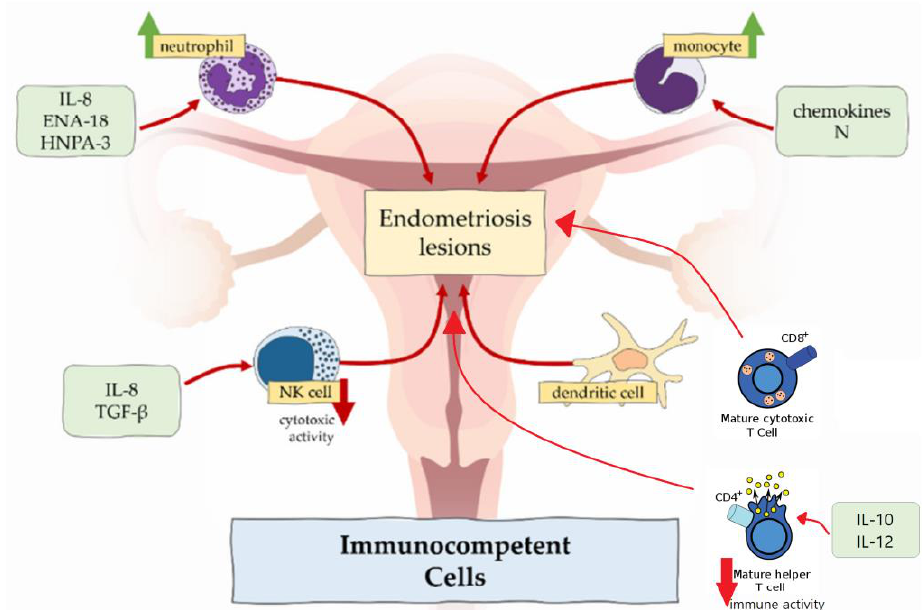
Figure 1. Immunocompetent cells in endometriosis. Figure replicated from [21] under Creative Commons license, provided at https://creativecommons.org/licenses/by-nc/4.0/ (accessed on 17 January 2023). Changes made: Figure legend, figure modification.